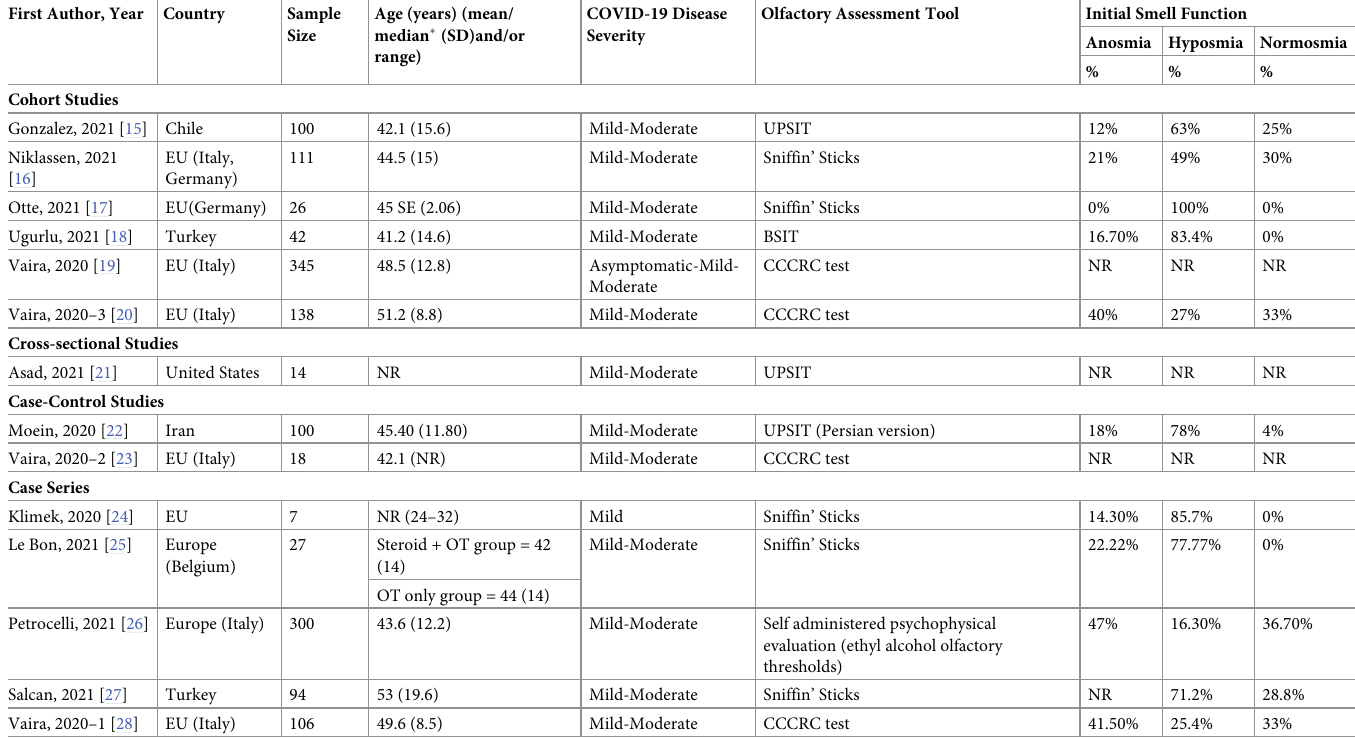
Table 1. Characteristics of studies that used objective olfactory